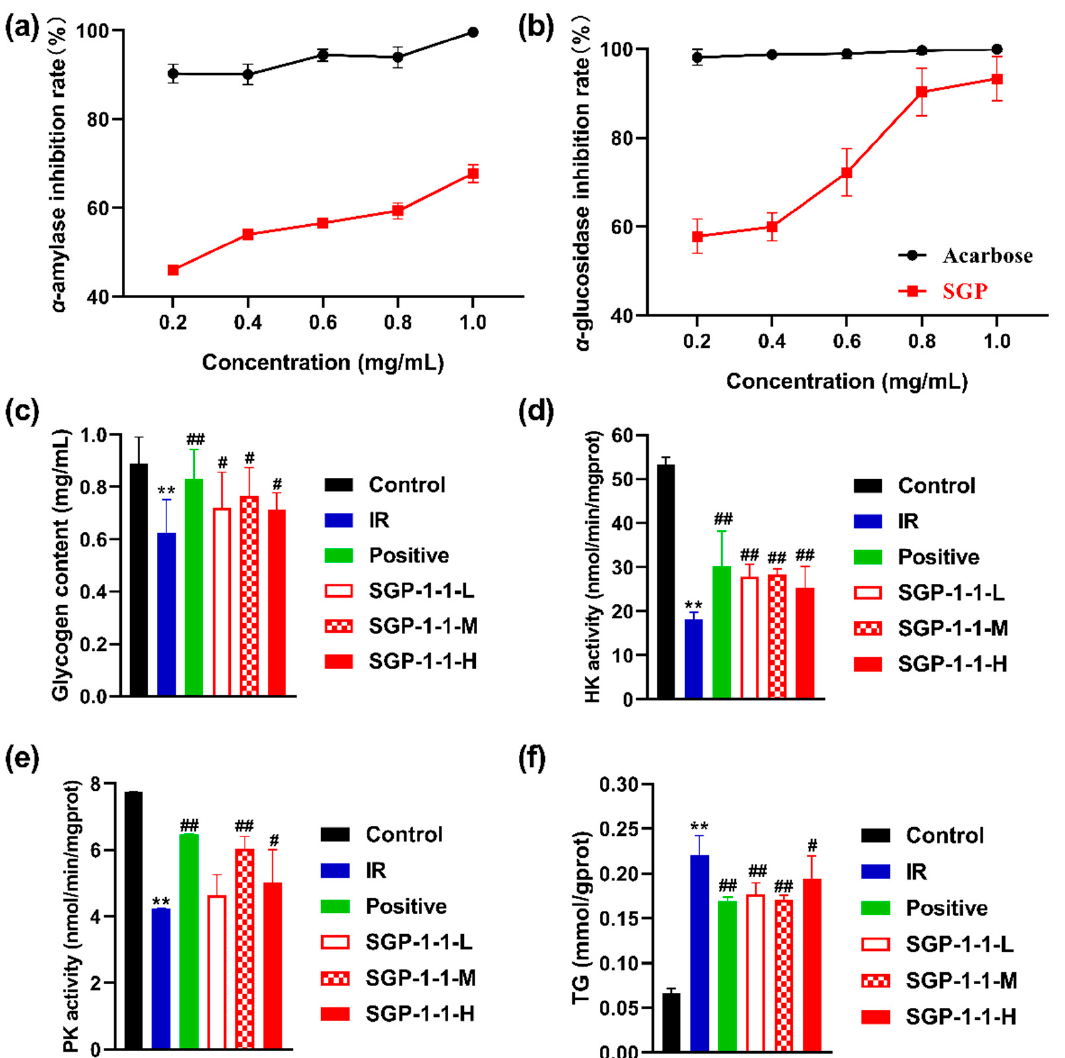
Figure 5. In vitro hypoglycemic activities of SGP-1-1. ( a ) Inhibition of α -amylase activities; ( b ) inhi- bition of α -glucosidase activities; ( c ) glycogen content of IR-HepG2 cells; ( d ) hexokinase (HK) and ( e ) pyruvate kinase (PK) activities of IR-HepG2 cells. ( f ) TG content of IR-HepG2 cells; compared to Control group, ** p < 0.001; compared to IR group, # p < 0.01, ## p < 0.001 (IR, insulin resistance; Positive, metformin-treated group).